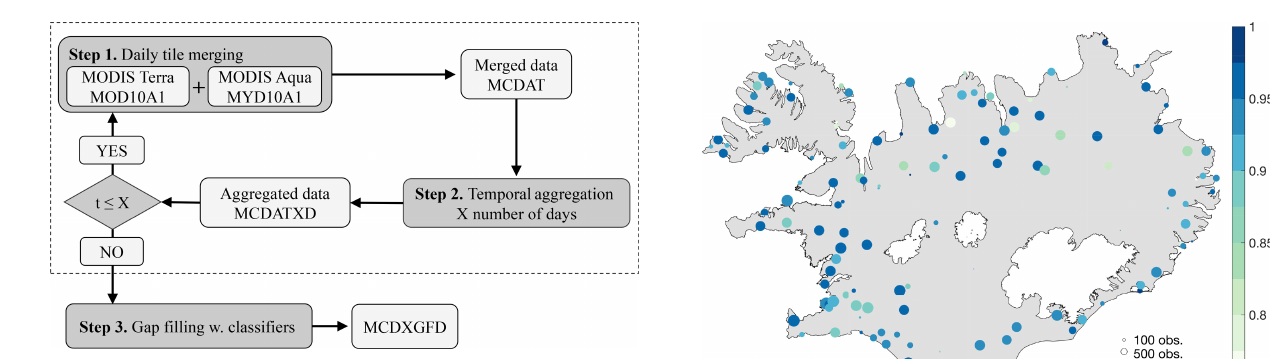
Figure 3. A simple process flow diagram for the daily tile merg- ing, temporal aggregation and gap filling. X denotes the number of days selected for temporal aggregation, which includes t number of aggregation steps.